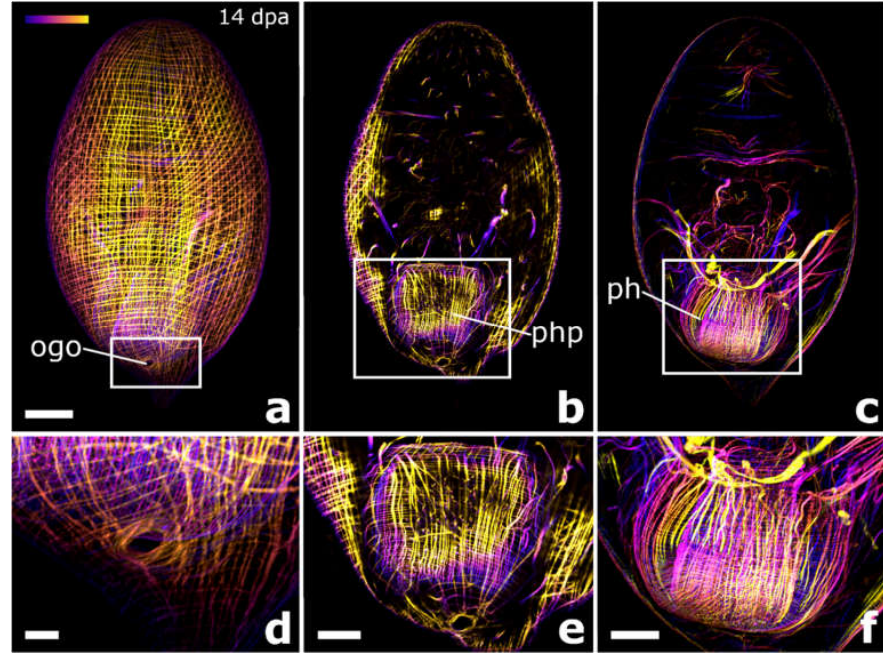
Figure 6. Musculature in posterior regenerates of Cylindrostoma monotrochum. F-actin stainings of a posterior regenerate 14 days after amputation through the pharynx. The regenerated orogenital opening at the posterior ventral part of the animal ( a and in detail in d ), the regenerated pharynx pouch ( b and in detail in e ), and the regenerated pharynx ( c and in detail in f ). The depth colour-coded projections show the same individual as in Figure 4k–n. Blue is more dorsal and yellow is more ventral in all pictures. Abbreviations: ogo, orogenital opening; ph, pharynx; php, pharyngeal pouch. Scale bars: 50 µ m in ( a ) (same for b and c ); 10 µ m in ( d ) and 25 µ m in ( e , f